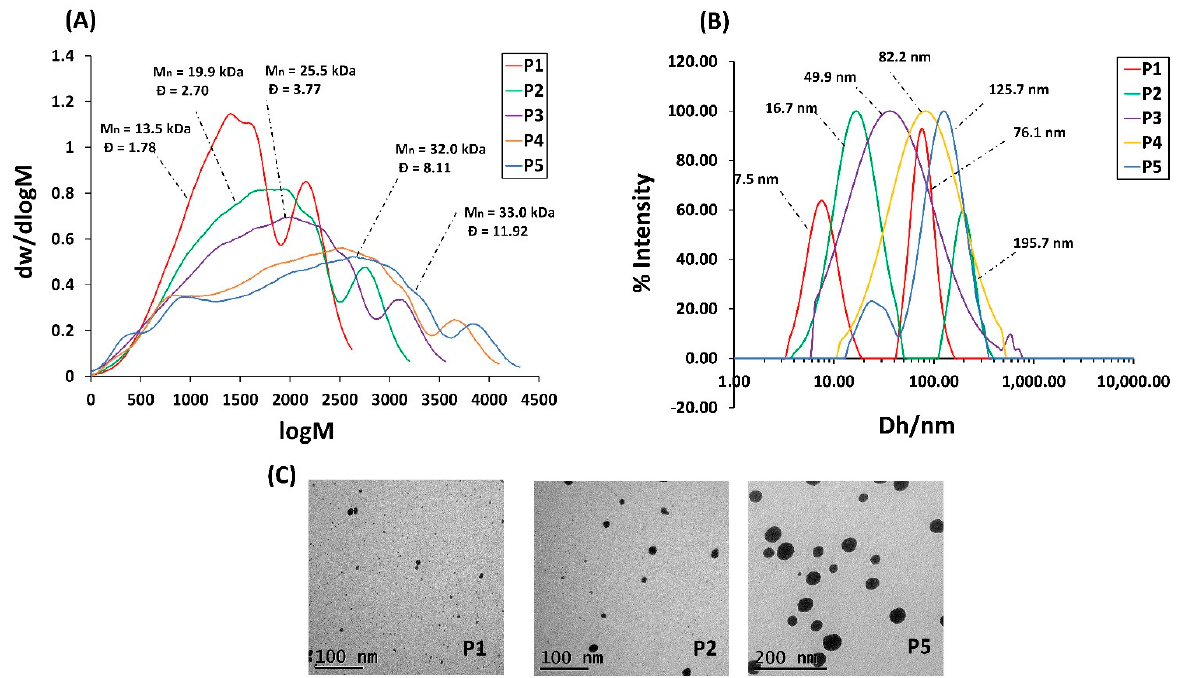
Figure 1. ( A ) Molecular weight distribution of HBPs derived from DMF GPC. ( B ) Particle size distribution of HBPs derived from DLS in water operated at 25 ◦ C. ( C ) TEM images of HBPs stained by uranyl formate.